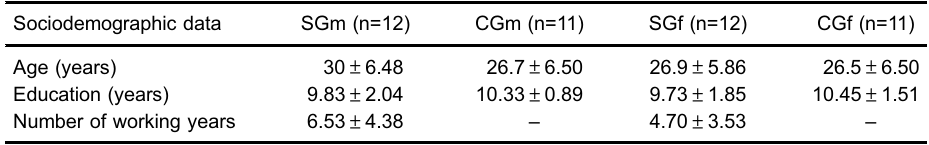
Table 1. Sociodemographic data of study and control male groups (SGm and CGm) and study and control female groups (SGf and CGf). Sociodemographic